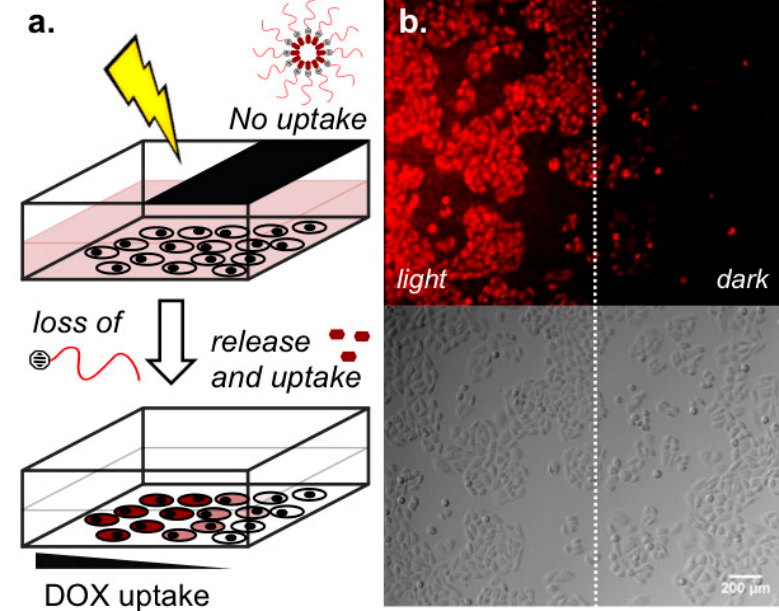
Figure 4. Light templated doxorubicin delivery in vitro. Patterned light (365 nm, 15–17 mW/cm 2 ) activation of 1 (300 µM) and cellular uptake of DOX ( red ).